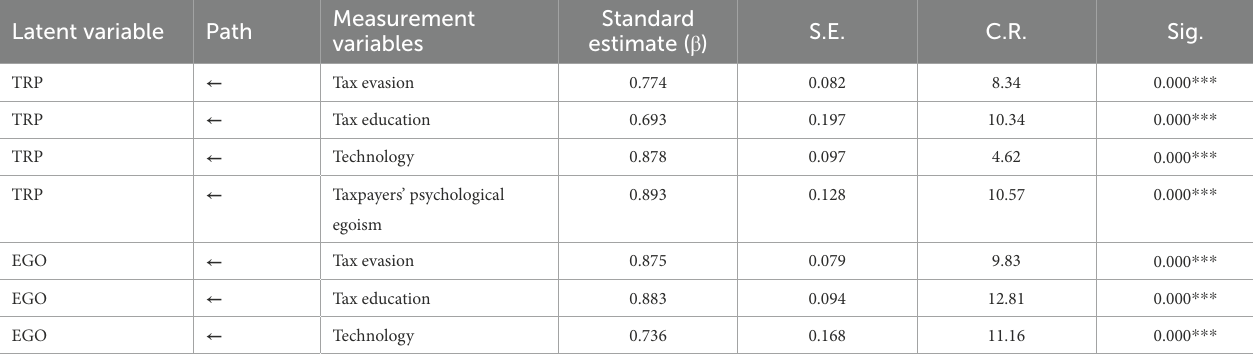
TABLE 3 Regression weights for the level of significant and critical ratio. Latent